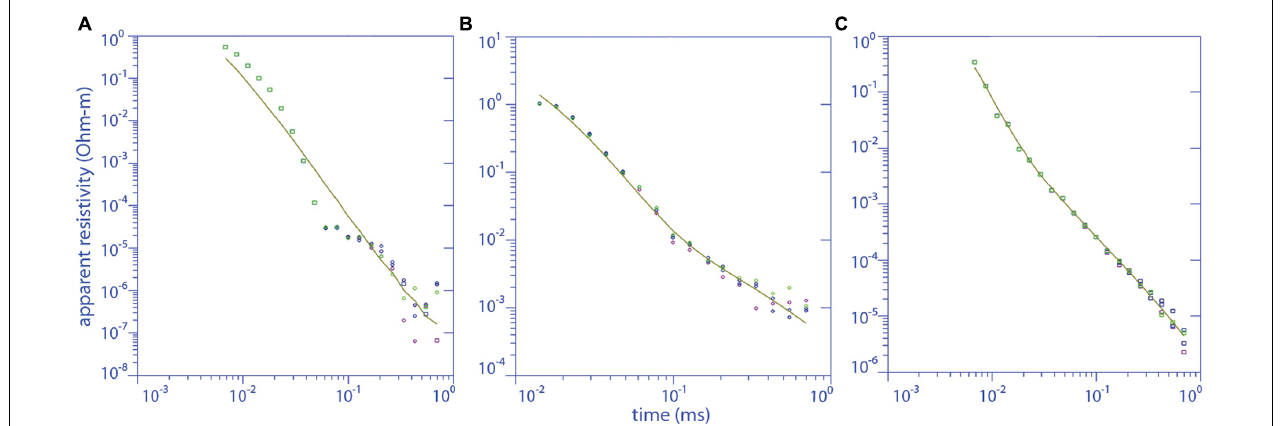
FIGURE 5 | Representative data fits to the G-TEM sounding curves for (A) 10 m × 10 m central-loop sounding on the beach, (B) 10 m × 10 m, and (C) 40 m × 40 m central-loop soundings inland from the bluffs. The dots are the data and the lines are the model fits. Square symbols represent positive responses, whereas negative responses are displayed as diamond symbols. A change in sign in response is due to a change in sign of the vertical magnetic flux passing through the RX coil; such a sign-change is indicative of 2D or 3D structure since the magnetic flux of a transmitted eddy current diffusing into a 1D Earth must maintain the same sign at the center of the RX coil throughout the entire measurement time-window. The symbols are the measured data and the lines represent the best smooth-model response. Different symbols represent different repetitions of the sounding.